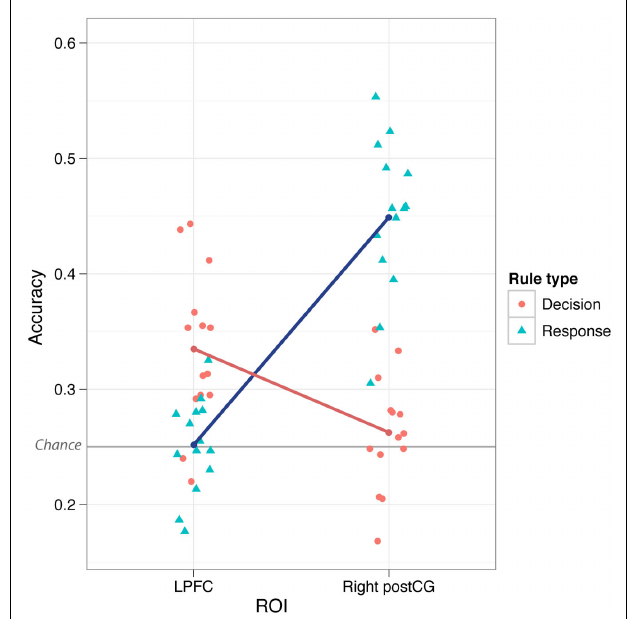
FIGURE 3 | Lateral prefrontal cortex vs. postCG double dissociation. Mean classification accuracy was significantly higher for decision vs. response rules in LPFC, but was significantly higher for response vs. decision rules in postCG (both right and left).This interaction was highly statistically significant ( p = 4.7e-07 for right postCG, p = 5.3e-06 for left postCG).The individual points in the plot are the classification accuracies for each subject